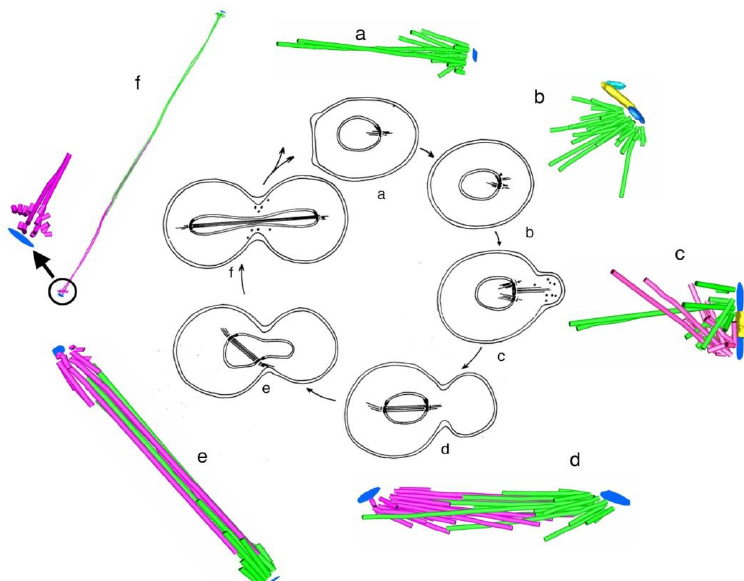
Figure 13. The spindle cycle in budding yeast. In the center of the figure, drawings represent the structure of budding yeast cells as they traverse the cell cycle. Around the edges are models made from tomographic reconstructions of the MT component of yeast spindles at each stage of mitosis. ( a ) There is only one centrosome but MTs grow from it into the cell’s nucleus; ( b ) The centrosome is duplicated and more shorter MTs project into the nucleus; ( c ) There are now two functional centrosomes, sitting side by side, each projecting MTs into the nucleus. At this stage, the spindle is in the process of attaching sister kinetochores to sister spindle poles; ( d ) A bi-polar spindle has formed; ( e ) The cell is advanced in anaphase B and the sister chromosomes are well separated; ( f ) A long, slender spindle runs from pole to pole (green and magenta MTs), and the chromosomes are drawn tightly around each pole. This spindle severs as the cell divides at cytokinesis, and the cell returns to state A. Redrawn from [43] by Eileen O’Toole. This image is displayed under the terms of a Creative Commons License (Attribution-Noncommercial-Share Alike 3.0 Unported license, as described at http://creativecommons.org/licenses/by-nc-sa/3.0/.